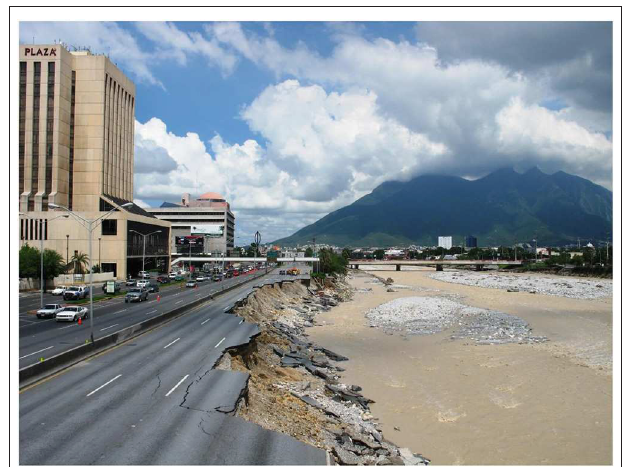
FIGURE 6 | Damages to urban metropolitan mobility infrastructure.